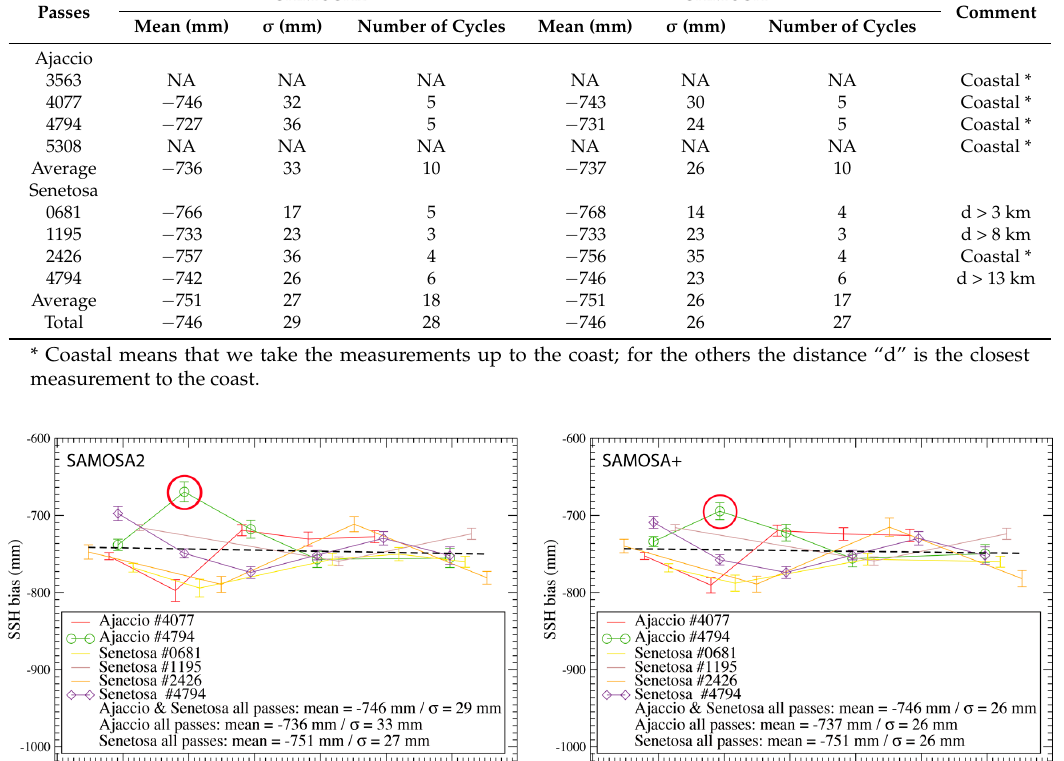
Table 3. Details of the SSH biases for each pass and for the two retrackers (SAMOSA2 and SAMOSA+). Passes